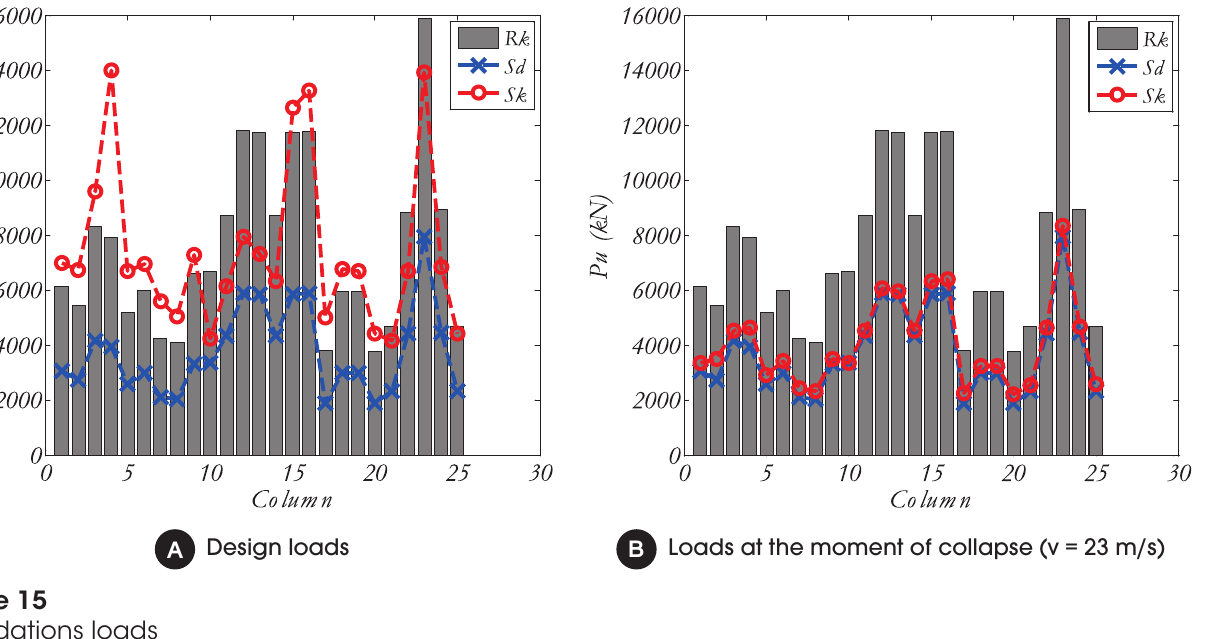
Foundations loads